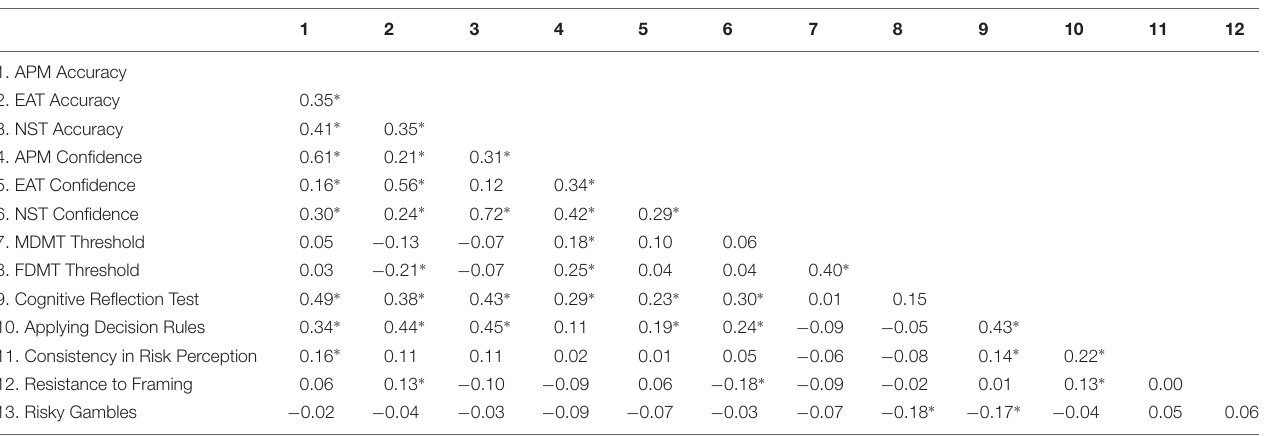
TABLE 2 | Correlations between retained